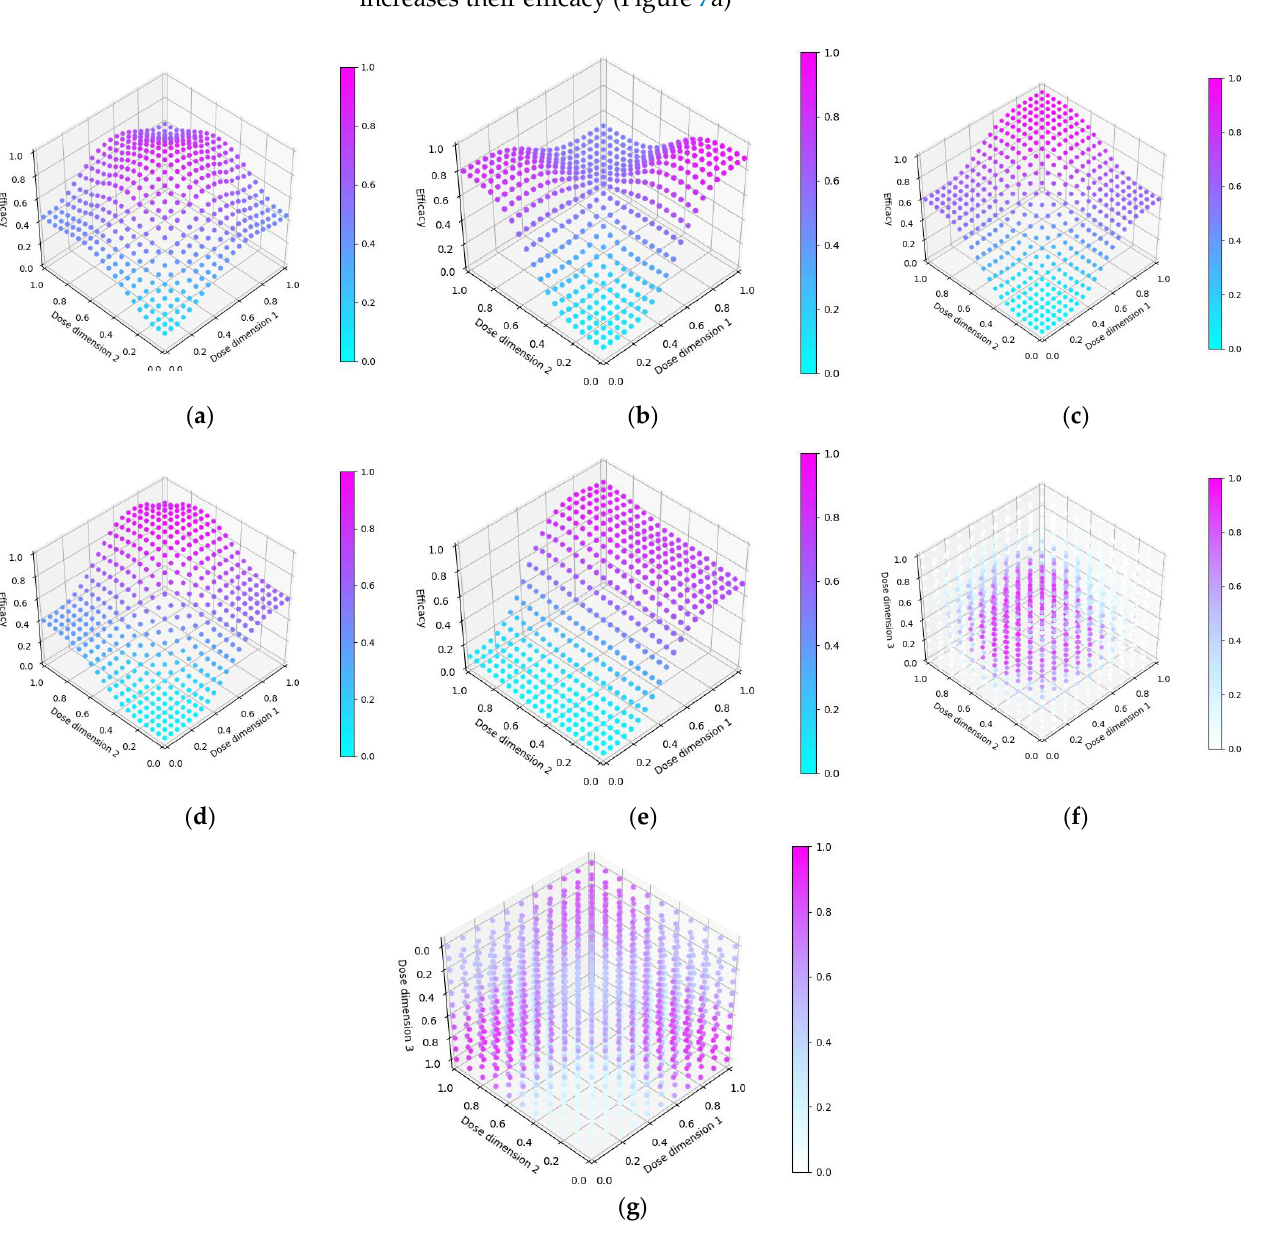
Figure 7. Dose-efficacy plots for the seven objective 2 scenarios. These were ( a ) scenario 1, ( b ) scenario 2, ( c ) scenario 3, ( d ) scenario 4, ( e ) scenario 5, ( f ) scenario 6, and ( g ) scenario 7. Purple represents areas of higher efficacy. Note the z -axis for ( g ) is inverted to better show the 3-dimensional dose-efficacy relationship.